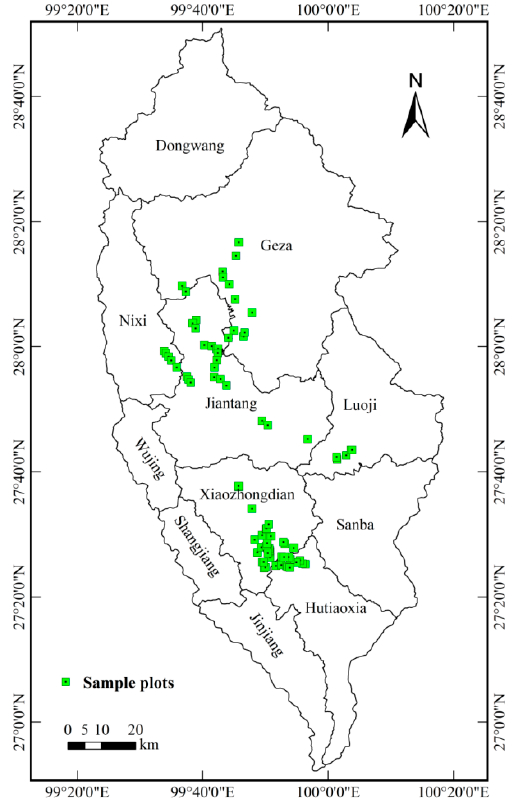
Figure 2. The location of study sites and the